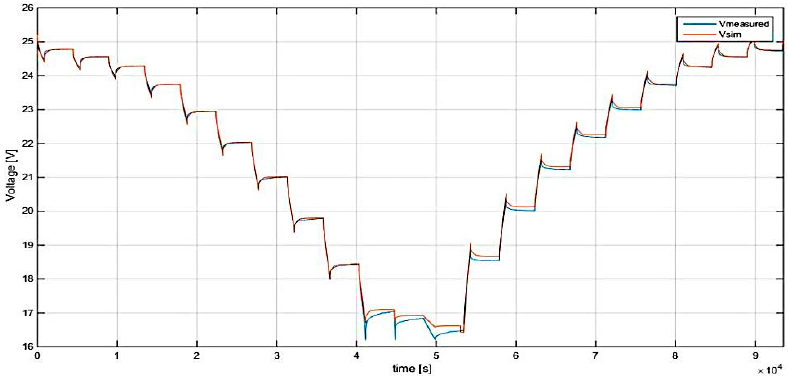
Figure 13. Measured voltage vs. simulated voltage.